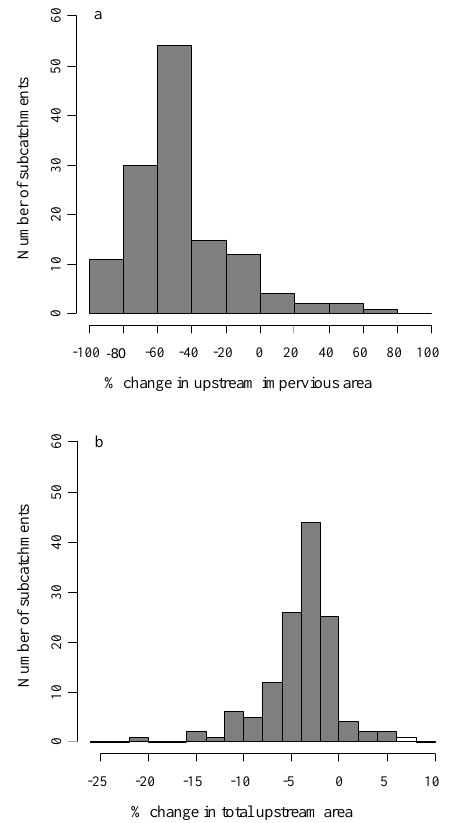
Fig. 7. (a) Histogram of the change in upstream impervious areas that demonstrates the impact of the sewer system on both upstream area calculations. For different stream junction points ( n =131) in the catchment, upstream impervious areas were calculated based on the natural catchment and after taking the sewer system into ac- count. Differences between both types of upstream impervious ar- eas were calculated as percentage change for each junction. (b) His- togram of the change in total upstream areas that demonstrates the impact of the sewer system on both upstream area calculations. For different stream junction points ( n =131) in the catchment, total up- stream areas were calculated based on the natural catchment and af- ter taking the sewer system into account. Differences between both types total upstream areas were calculated as percentage change for each